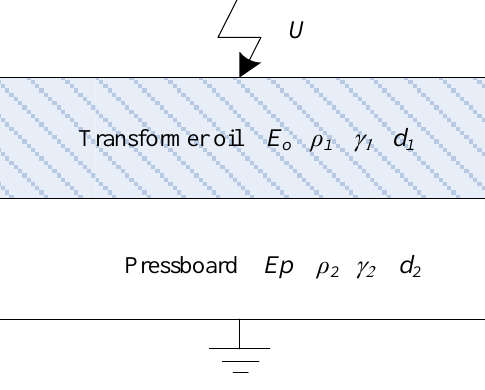
Transformer oil